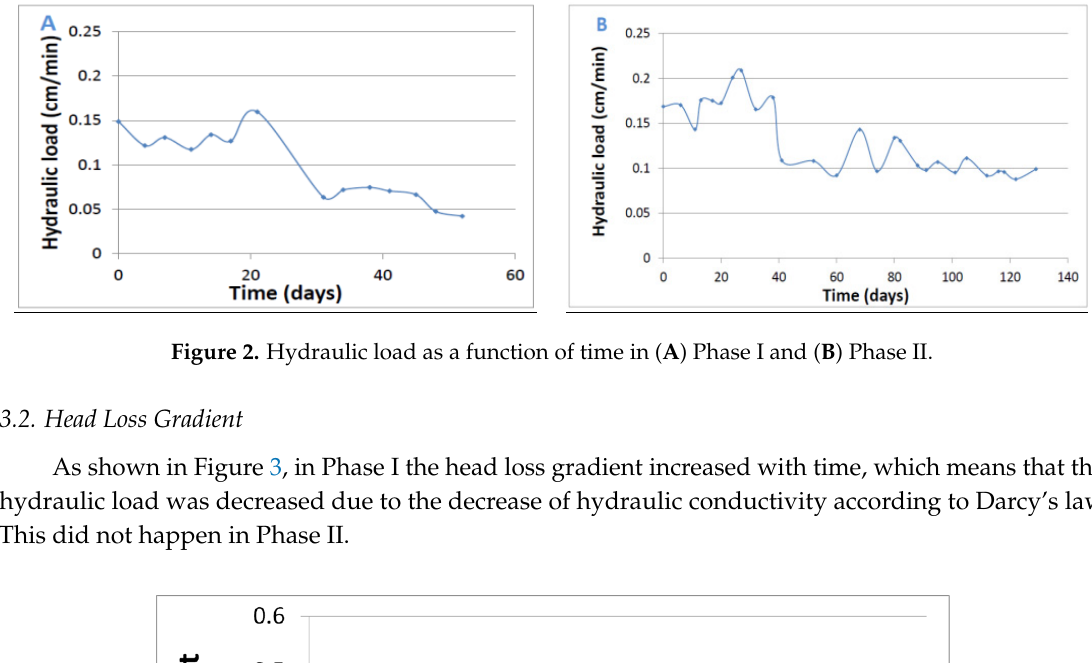
Figure 4. Nitrate concentration relative to inlet concentration as a function of time and distance along the column in ( A ) Phase I and ( B ) Phase II.